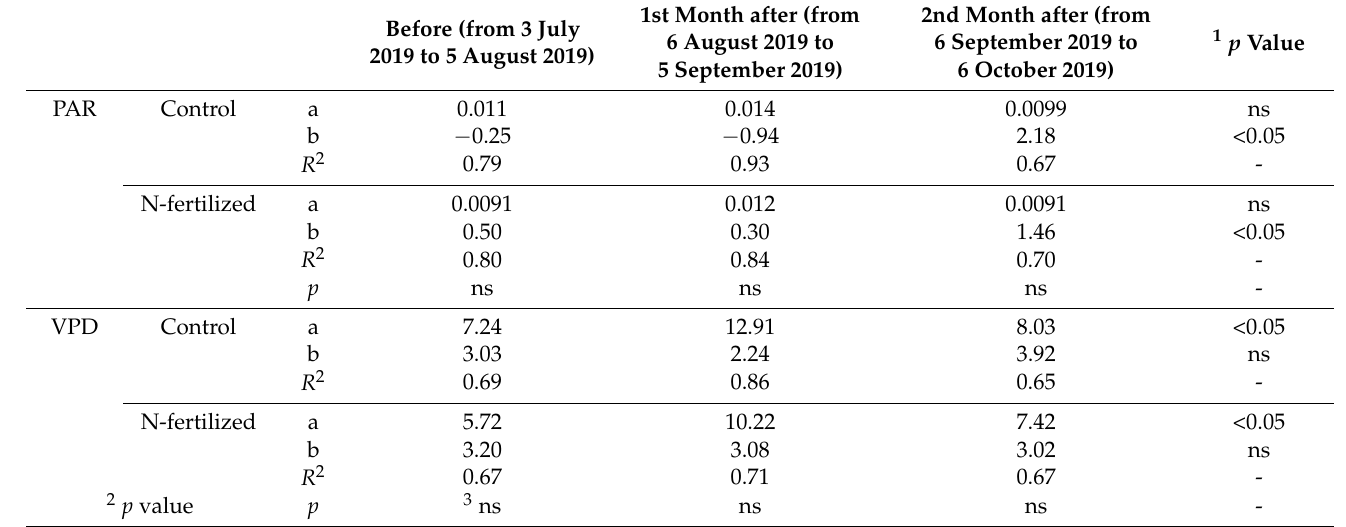
Table 4. Summary of ANCOVA to examine significant difference for the daytime mean sap flow density (SFD) vs. meteorological conditions such as photosynthesis active radiation (PAR) and vapor pressure deficit (VPD) between the control and the N-fertilized in Figure 4.